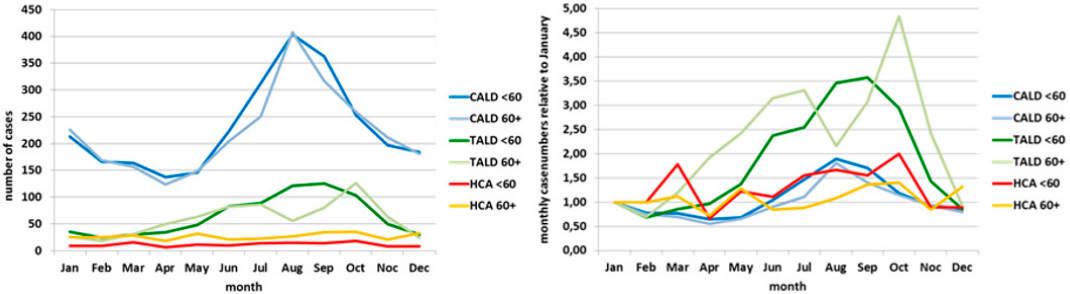
Figure 1. Left panel: absolute case numbers by month and exposure category; Germany, pooled data 2005–2015 . Right panel: monthly case numbers (relative to January) by month and exposure category; Germany, pooled data 2005–2015.